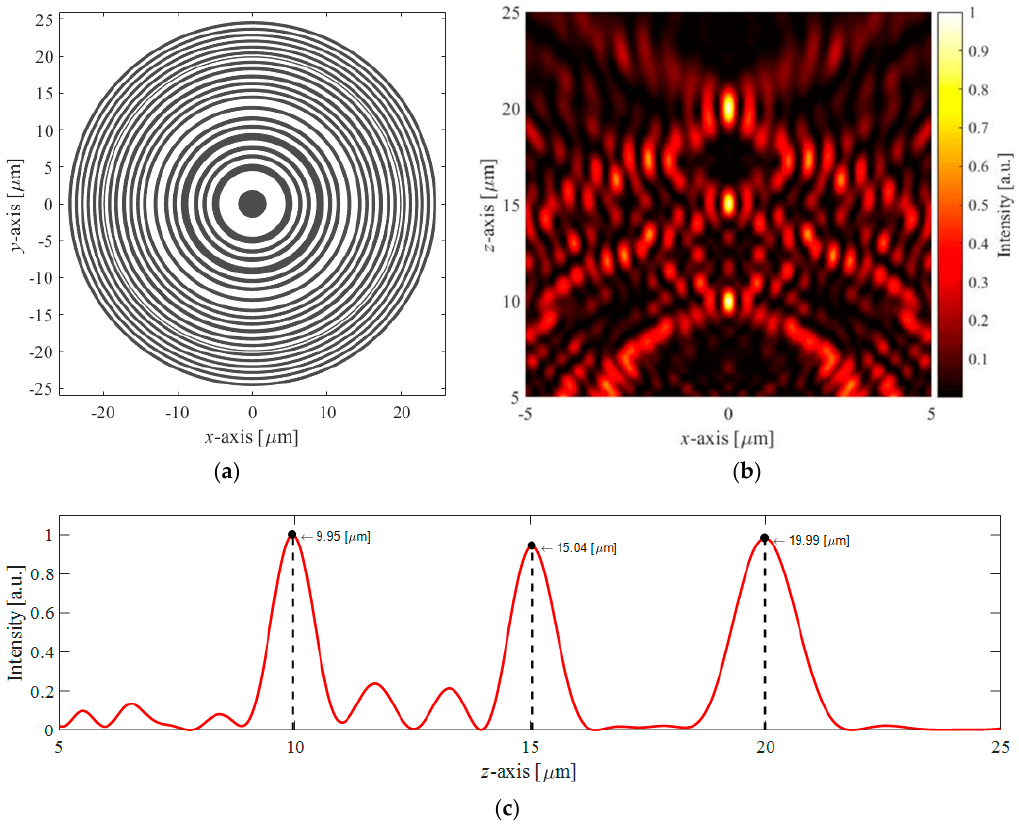
Figure 2. Simulation results on the monochromatic, multi-focal MFZP specified in Table 1: ( a ) Shape of the calculated MFZP pattern. ( b ) Calculated intensity pattern formed through the MFZP. ( c ) Calculated intensity profile on the center axis of the MFZP, i.e., the z -axis.